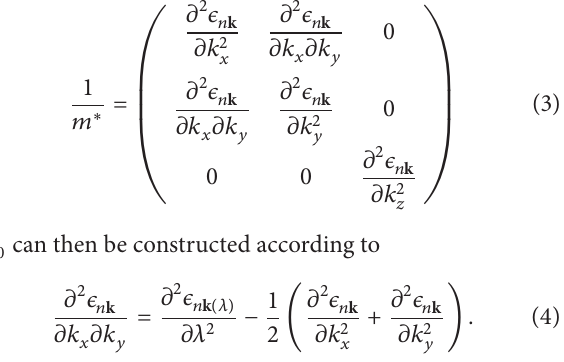
step, we determine the position k 0 of a band minimum in the 𝑘 𝑧 = 0 plane using a two-dimensional steepest descent method. Subsequently, we calculate the curvatures 𝜕 2 𝜖 𝑛 k /𝜕𝑘 2 𝛼 with 𝛼 ∈ {𝑥, 𝑦, 𝑧} at the band minimum from polynomial fits on a dense mesh of k points along the three Cartesian axes as well as 𝜕 2 𝜖 𝑛 k (𝜆) /𝜕𝜆 2 along a diagonal path in the [110] direction parametrized by k (𝜆) = k 0 + 𝜆(1, 1, 0)/√2 . The